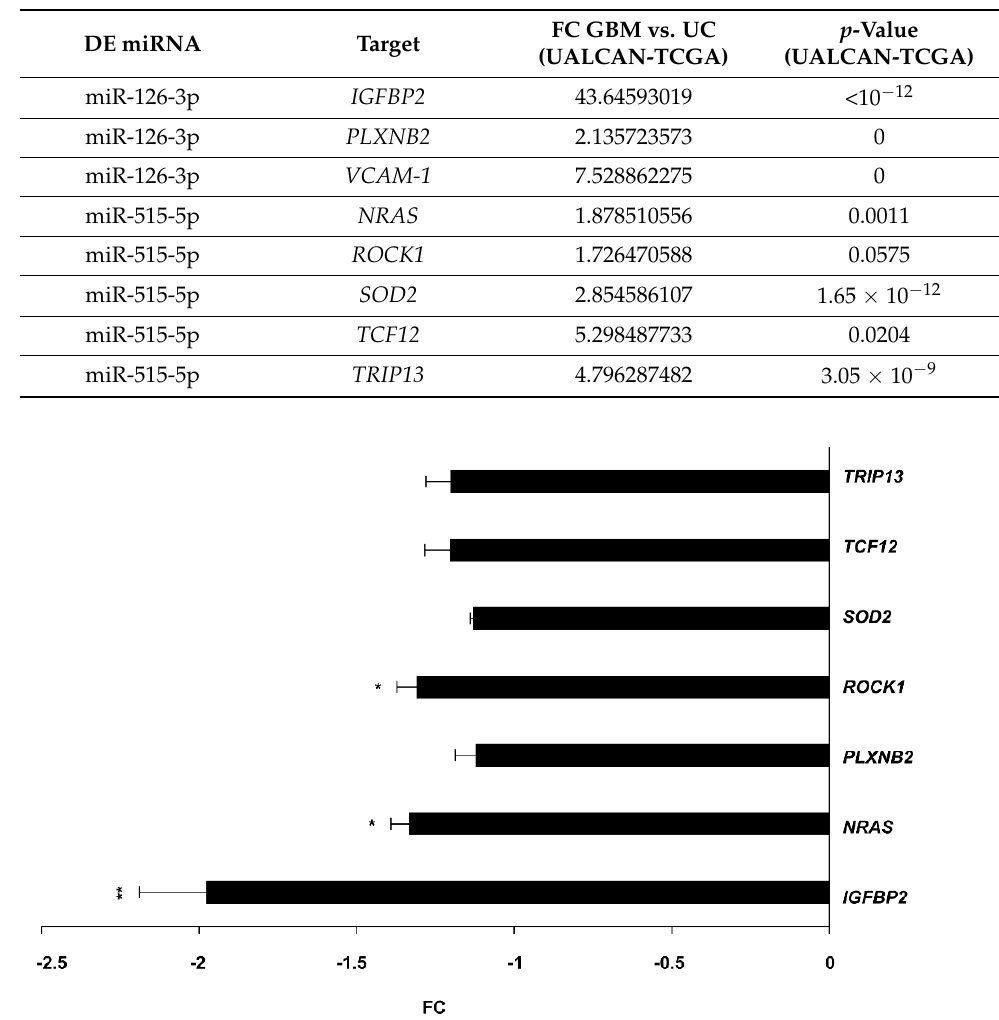
Figure 4. Expression of candidate DE miRNA targets in U87MG overexpressing circSMARCA5. Data are reported as fold-change (FC) of the expression of candidate miRNA targets in U87MG transfected with pcDNA3_circSMARCA5 vs . NCs. * p -value < 0.05, ** p -value < 0.01 ( n = 3, Student’s t -test).